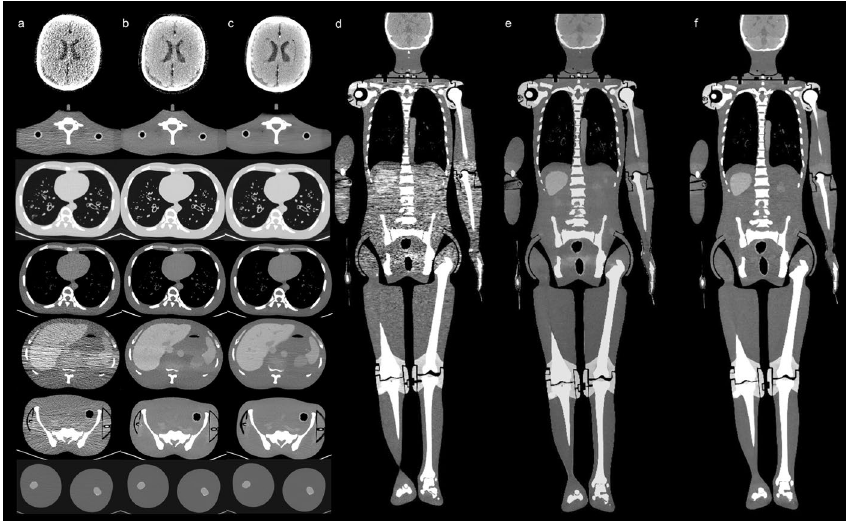
Fig. 2 CT images of the anthropomorphic phantom with ULDCT and SDCT scanning. ( a – c ) column: the transverse section of different anatomy location of ULDCT-HIRphantom, ULDCT-AIIRphantom and SDCT-HIRphantom. ( d – f ): the coronal section of ULDCT-HIRphantom, ULDCT-AIIRphantom and